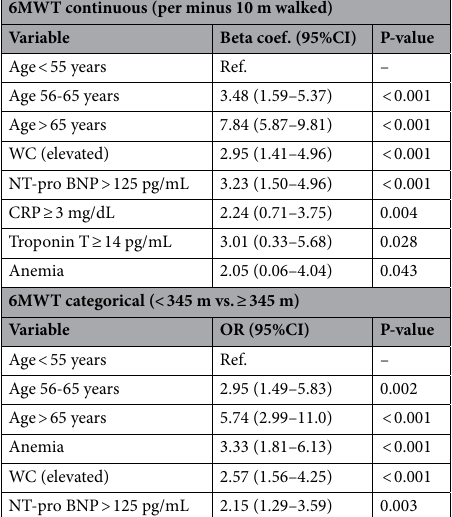
Table 2. Factors independently associated with less distance walked in the 6MWT. WC, waist circumference ≥ 102 cm in men and ≥ 88 cm in women; NT-pro BNP, N-terminal pro brain natriuretic peptide; CRP, C-reactive protein; OR, odds ratio. All variables with a P-value of less than 0.05 in Table 1 were entered a stepwise forward model and Table 2 presents the variables retained in the final model. The beta coefficient represents an association of the variables per each minus 10 m walked from a linear regression model. The OR represents an association of the variables with walking less than 345 m in 6MWT from a logistic regression model.